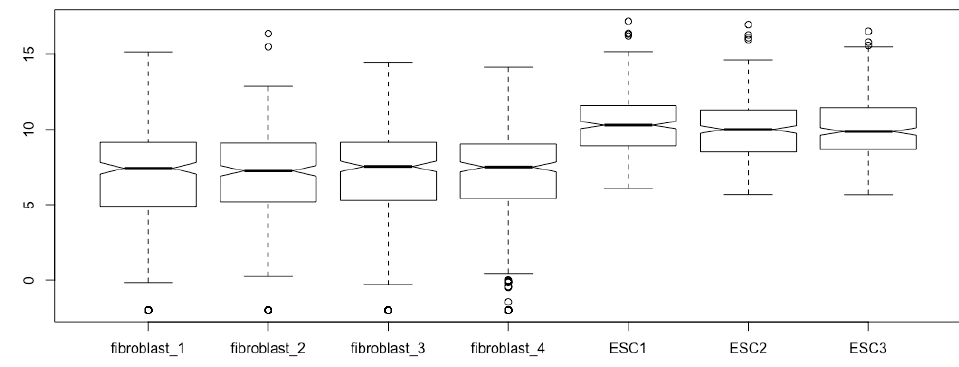
Figure 6. Add notches to boxplots using the argument notch = TRUE.